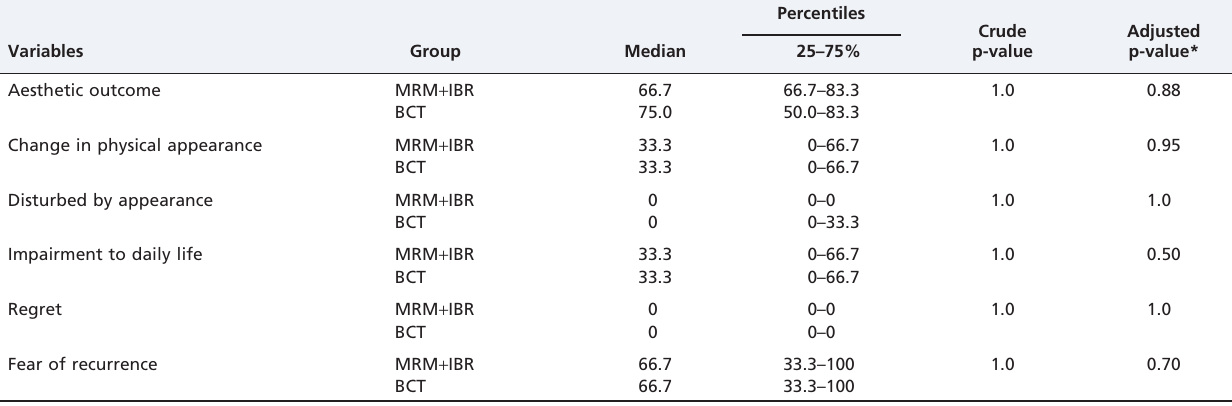
Table 5 - Comparison between the median scores of patient satisfaction with surgery in women with breast cancer submitted to MRM + IBR (n= 26) or BCT (n=